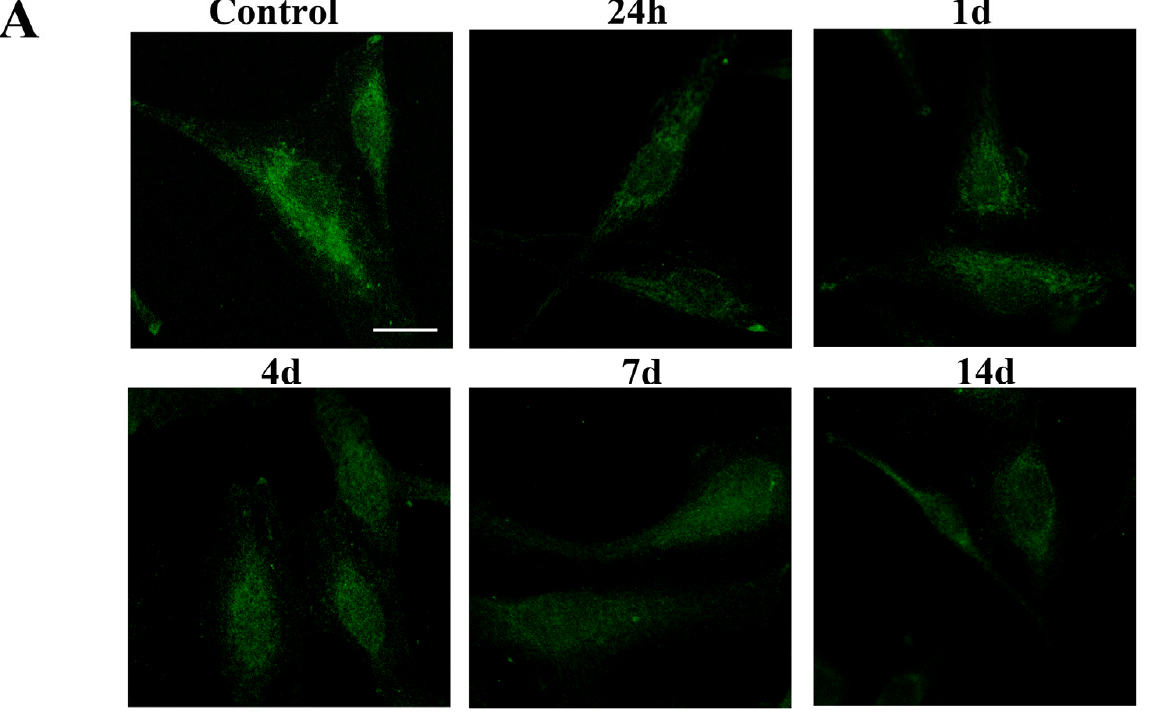
Figure 1. Rapamycin produces a long ‐ lasting inhibition of mTOR activity. ( A ) Representative pic ‐ tures showing the immunofluorescence of the protein PS6RP, which is a downstream enzymatic product of mTOR. Rapamycin produces a marked and long ‐ lasting decrease of the PS6RP immu ‐ nofluorescence. Densitometry of the PS6RP immunofluorescence ( B ) and the representative PS6RP immunoblotting ( C ) indicate that rapamycin induces a massive mTOR inhibition, which lasts at least 14 days following rapamycin withdrawal. Data in ( B ) are given as the mean percentage ± SEM. of optical density measured in 100 cells per group (assuming controls as 100%). * p < 0.05 compared with controls. Scale bar = 12 μ m.